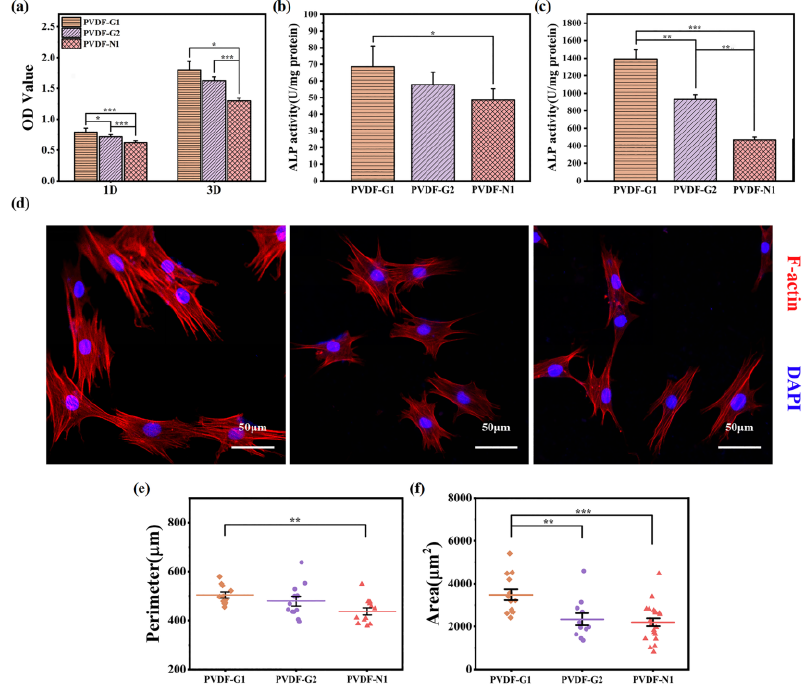
Figure 4. ( a ) The adhesion (1 d) and proliferation (3 d) behaviors of MSCs on P(VDF-TrFE) coatings. ( b , c ) ALP activities of MSCs on P(VDF-TrFE) coatings after culture for 7 days and 14 days. ( d ) The CLSM images of MSCs on P(VDF-TrFE) coatings for 3 days. ( e , f ) Cytomorphometric evaluations of MSCs on P(VDF-TrFE) coatings perimeter and spread area for 3 days (* p < 0.05, ** p < 0.01, *** p < 0.001).